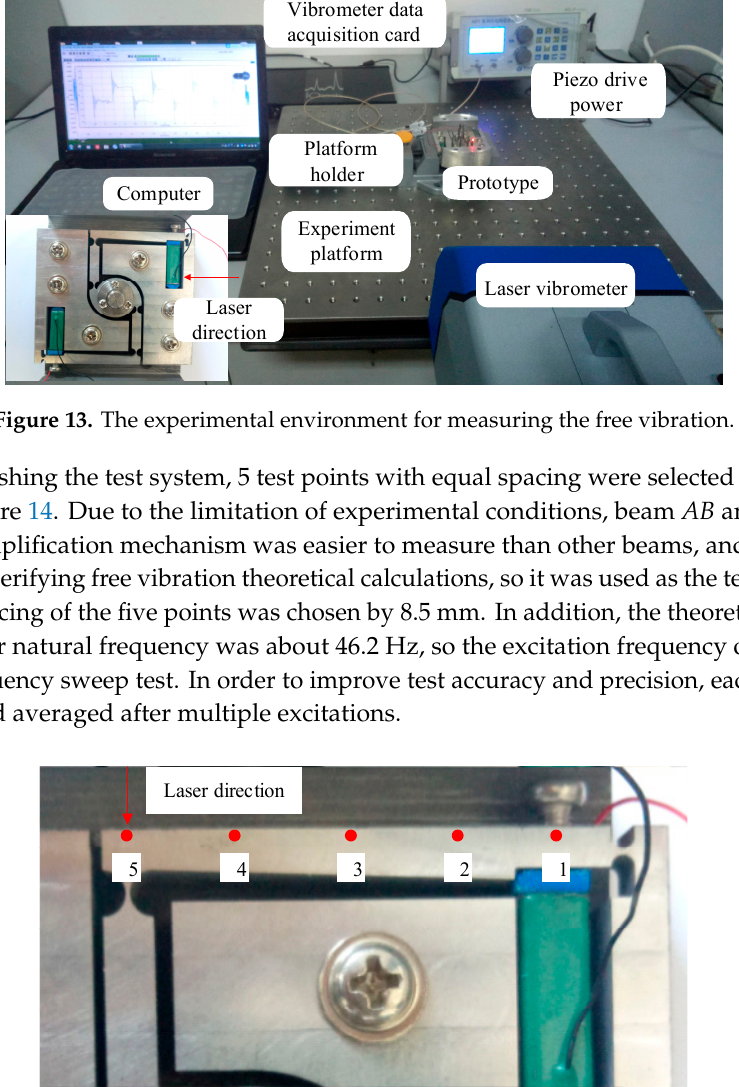
Figure 12. Flow chart of the free vibration test system.